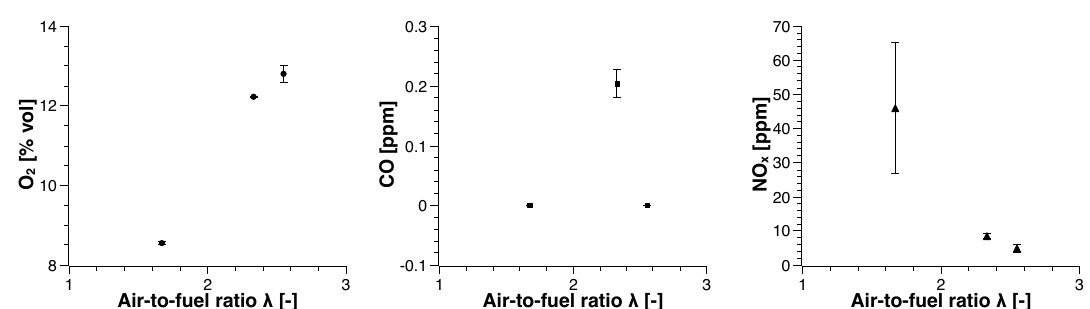
Figure 11. Concentrations of O 2 (% vol), CO (ppm), and NO x (ppm) as a function of air-to-fuel ratio λ . Air inlet temperature 500 ◦ C.